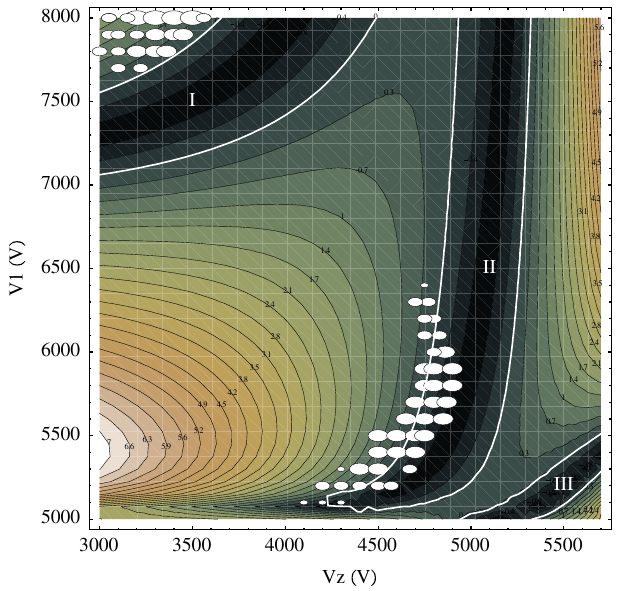
FIG. 10. The contours show the iso- (cid:11) values where (cid:11) ¼ j (cid:3) j (cid:1) 1 . The stability region is defined by (cid:11) < 0 . The white dots indicate settings where trapping was experimentally observed. The radius of each dot is proportional to the trapping efficiency. The thick white line is the border of the three stability regions: there are three stability zones marked I, II, and III corresponding to the three types of orbits of Fig. 11. We used ¼ 5850 V , , V O 4 þ at 5.2 keV/charge and the potential set is ( V 1 2 ¼ 4150 V , V ¼ 1650 V , V V z 3 4